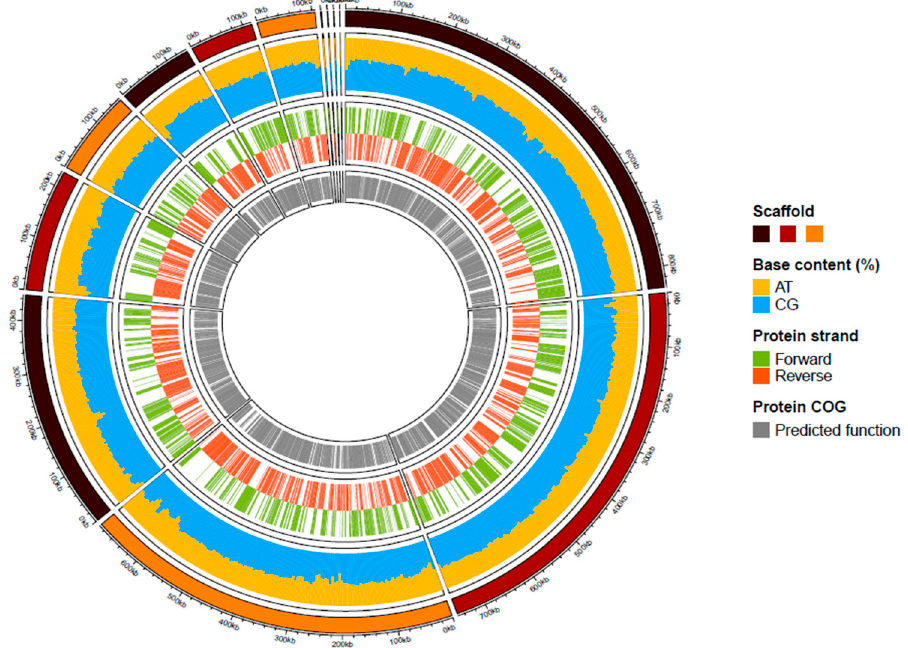
Figure 3. Graphical circular map of the genome of strain kh20 T . From outside to the center: Scaffolds